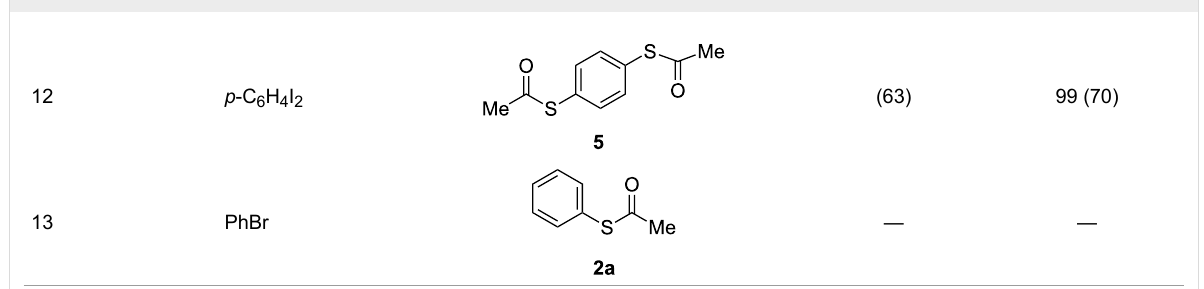
Table 3: Copper-catalyzed reaction of aryl iodides with potassium thioacetate ( 1 ). a (continued)